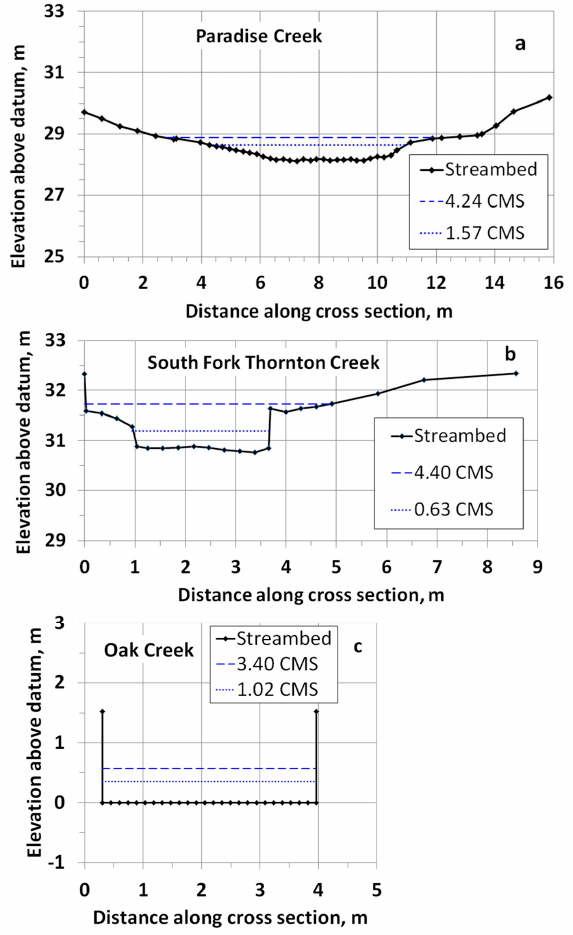
Figure 3. Channel cross sections used in the model. Also shown are water surface elevations for the greatest and smallest sample discharges, in m 3 /s.